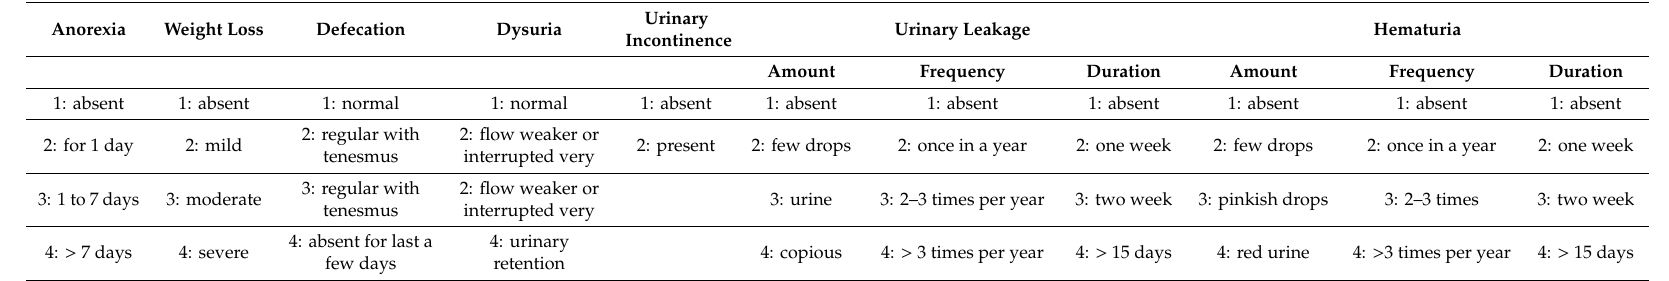
Table 2. The objective score system for benign prostate hyperplasia (BPH) signs grading, after Zambelli et al